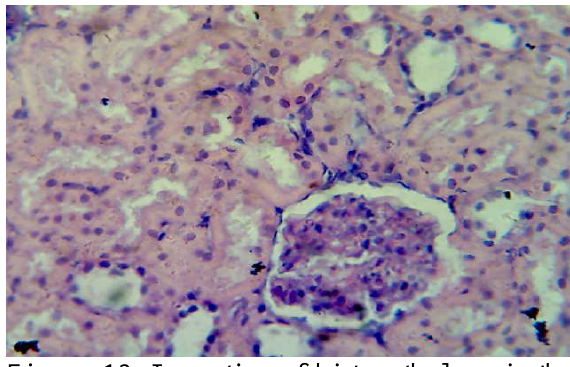
Figure, 13. In section of histopathology in the kidney of rat receiving 250mg/kg B.W. of betaine for 65 days in (G2 group): showed normal structure (H. & E. stain 400X).